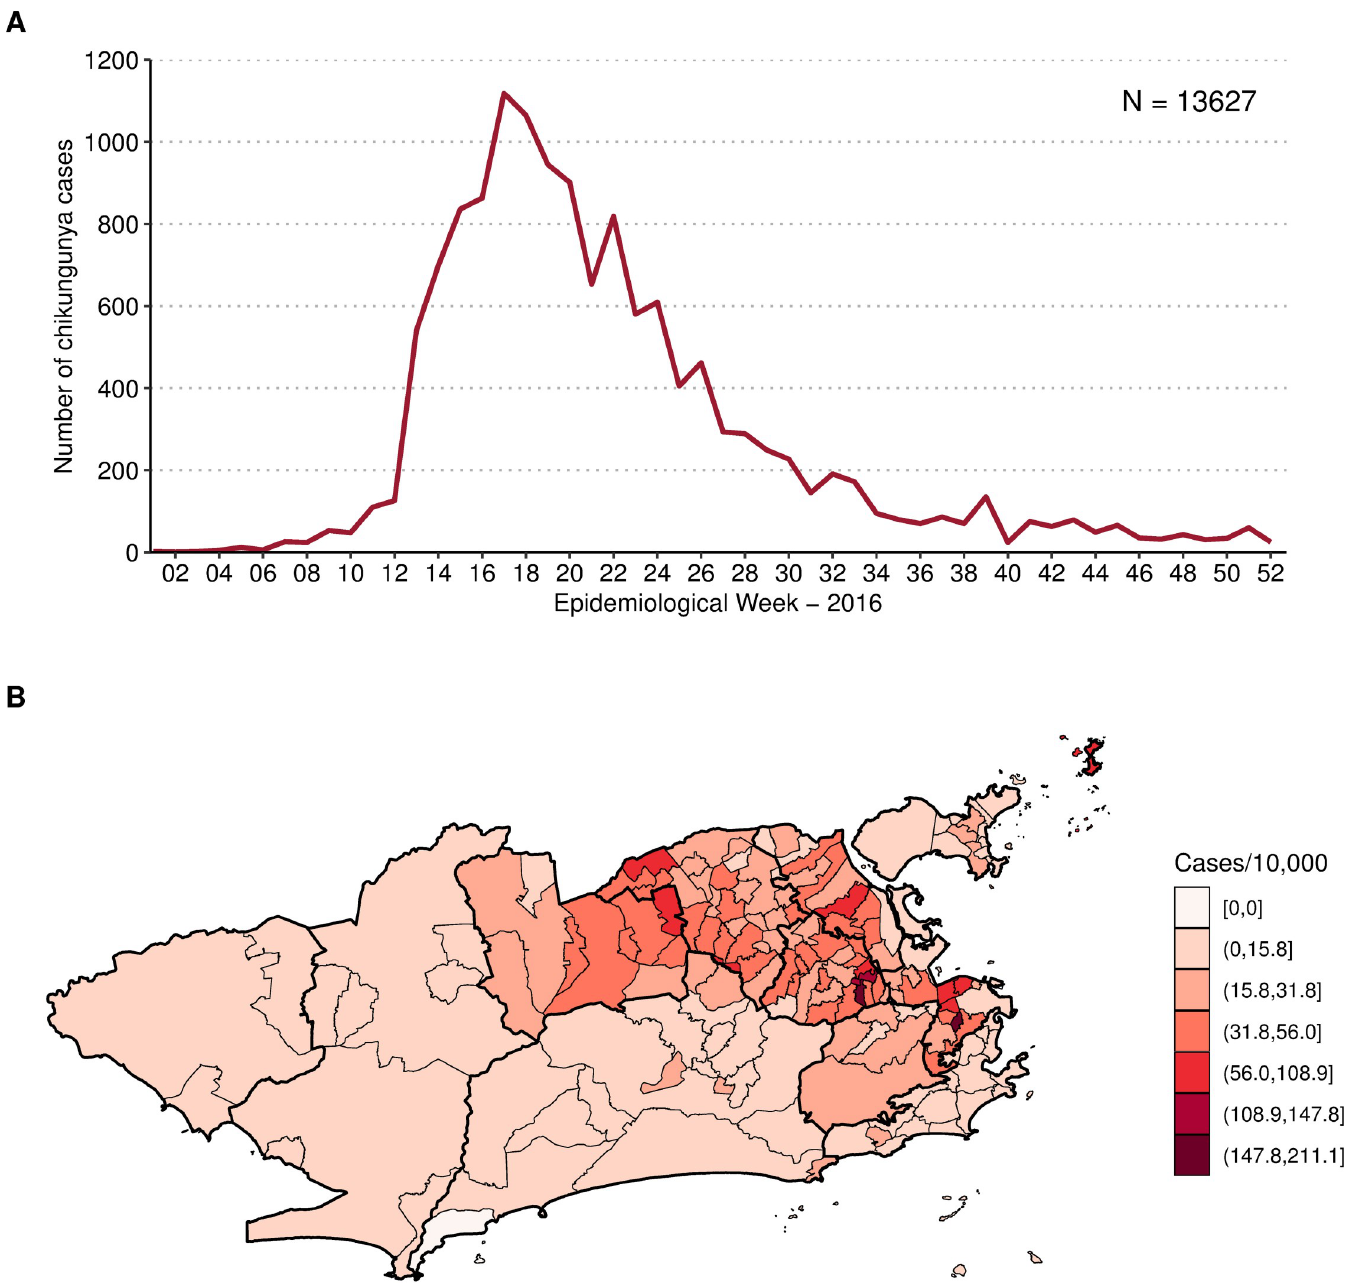
Fig 3. Notified chikungunya cases by week (A) and chikungunya cases cumulative incidence per 10,000 inhabitants by neighbourhood (B), January to December 2016, Rio de Janeiro city, Brazil. Map created using R version 3.6.1. Map layers by Instituto Pereira Passos (https://www.data.rio/).